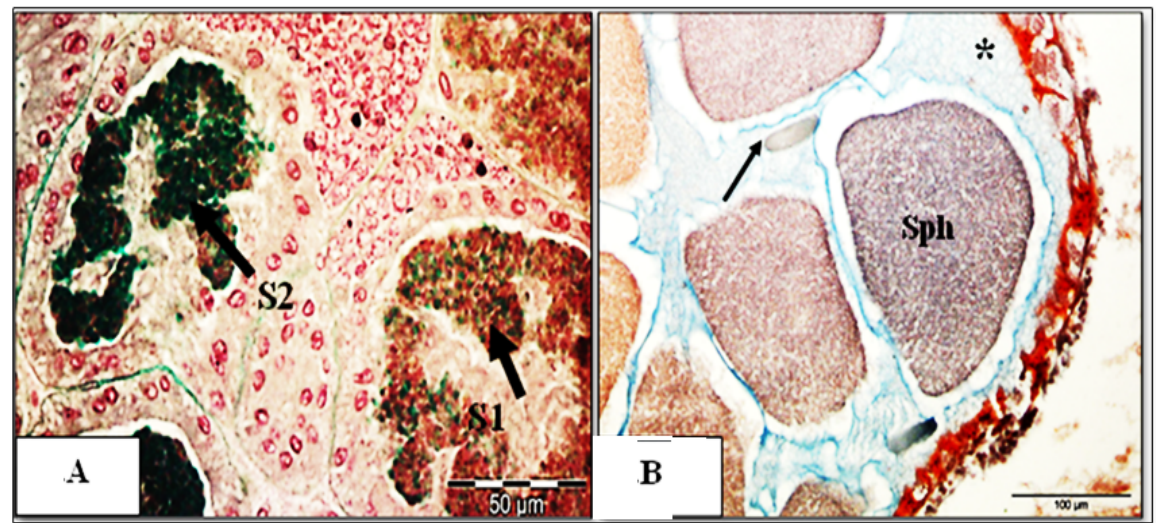
Figure 7. A photomicrograph of a transverse section of the testes of Callinectes sapidus showing evacuated duct with sperm and Secretion 1 (S1) (red color) and secretion 2 (S2) with (green color) (Masson trichrome stain) ( A ). A photomicrograph of a transverse section of the distal part of anterior vas deference Notice; spermatophore (Sph) with S5 (Star) and S6 secretions (black arrow) (Mallory triple Stain) ( B ).